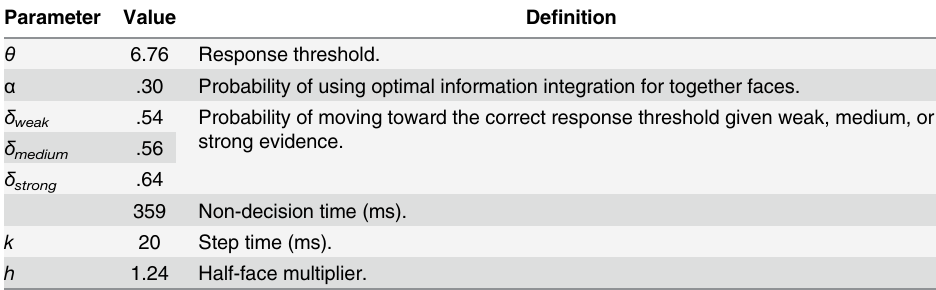
Table 2. Best Fitting Parameters for the McIA